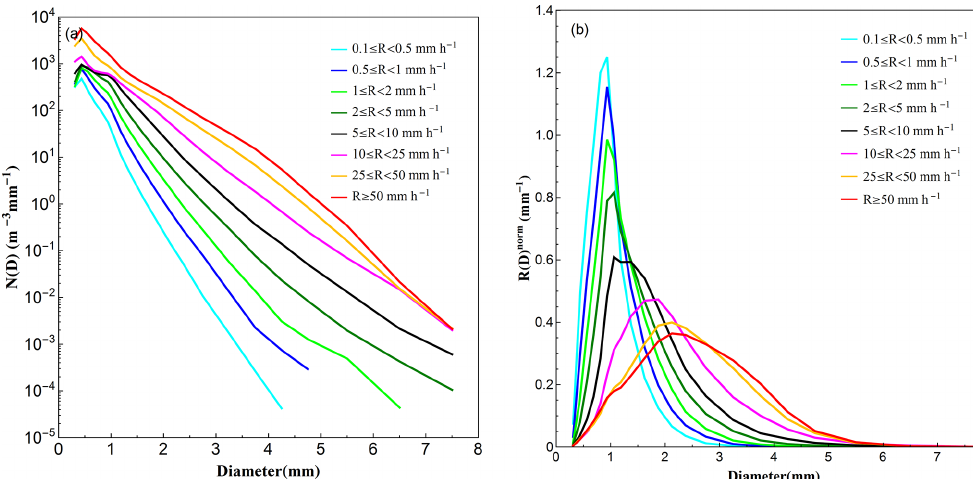
Figure 7. Same as Fig. 6 but for different rain rate